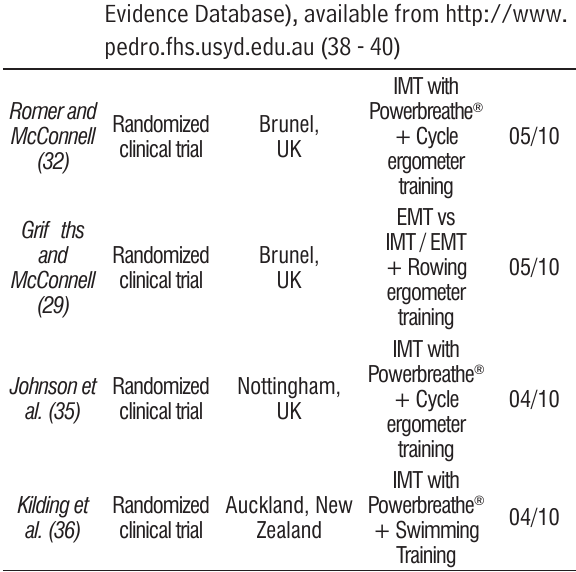
Table 2 - Inspiratory muscle training protocols (TMI) and as- sociation with the sport. IMT = Respiratory Muscle Training; MIP = maximal inspiratory pressure